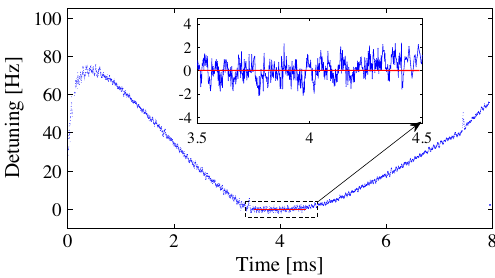
FIG. 4. Examples of cavity detuning on ML2 that operated at 10.5 MV in the pulse operation. The red line indicates the mean value of the detuning during the